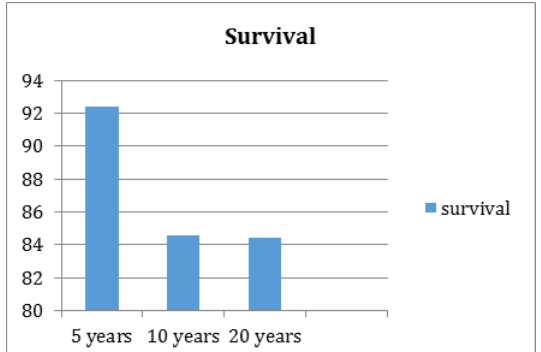
Figure 1. Actuarial survival of hospital survivors after double valve